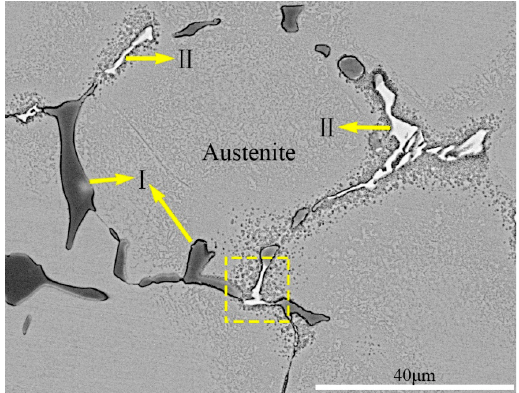
Figure 3. ( a ) Optical microscope (OM) images of as ‐ cast electroslag remelting (ESR) ingot microstructure; ( b ) highly magnified images taken at the region marked by the yellow box in ( a ). PC represents primary carbides or carbonitrides.